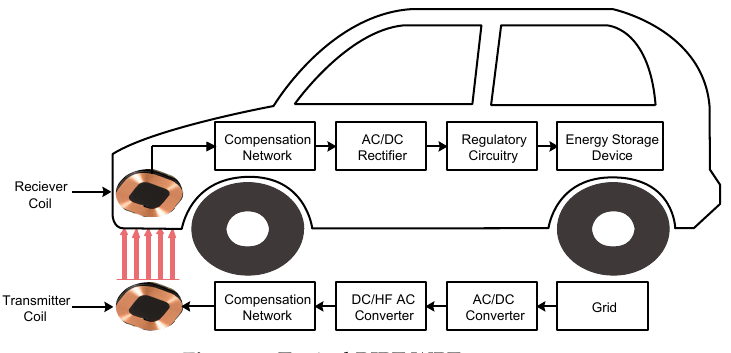
Figure 1. Typical RIPT WPT